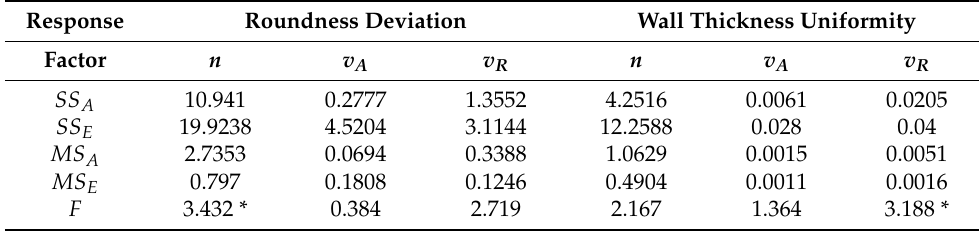
Table 2. One-way ANOVA analysis.